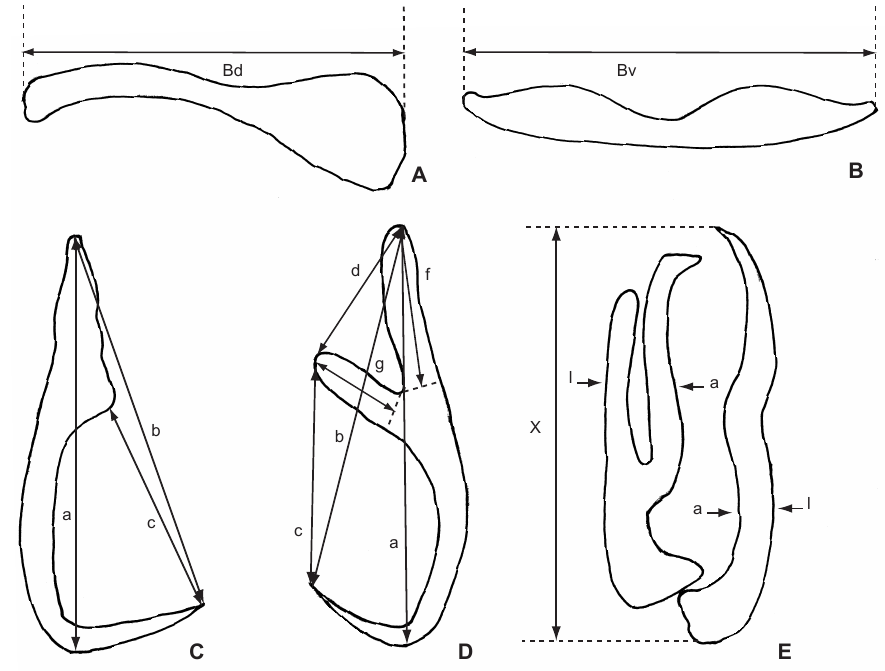
Fig. 1. – Lamellodiscus Johnston et Tiegs, 1922. Nomenclature utilisée pour la mensuration des pièces sclé- rifiées. Abréviations - A : barres laté- rales dorsales (Bd : longueur). B : barre médiane ventrale (Bv :